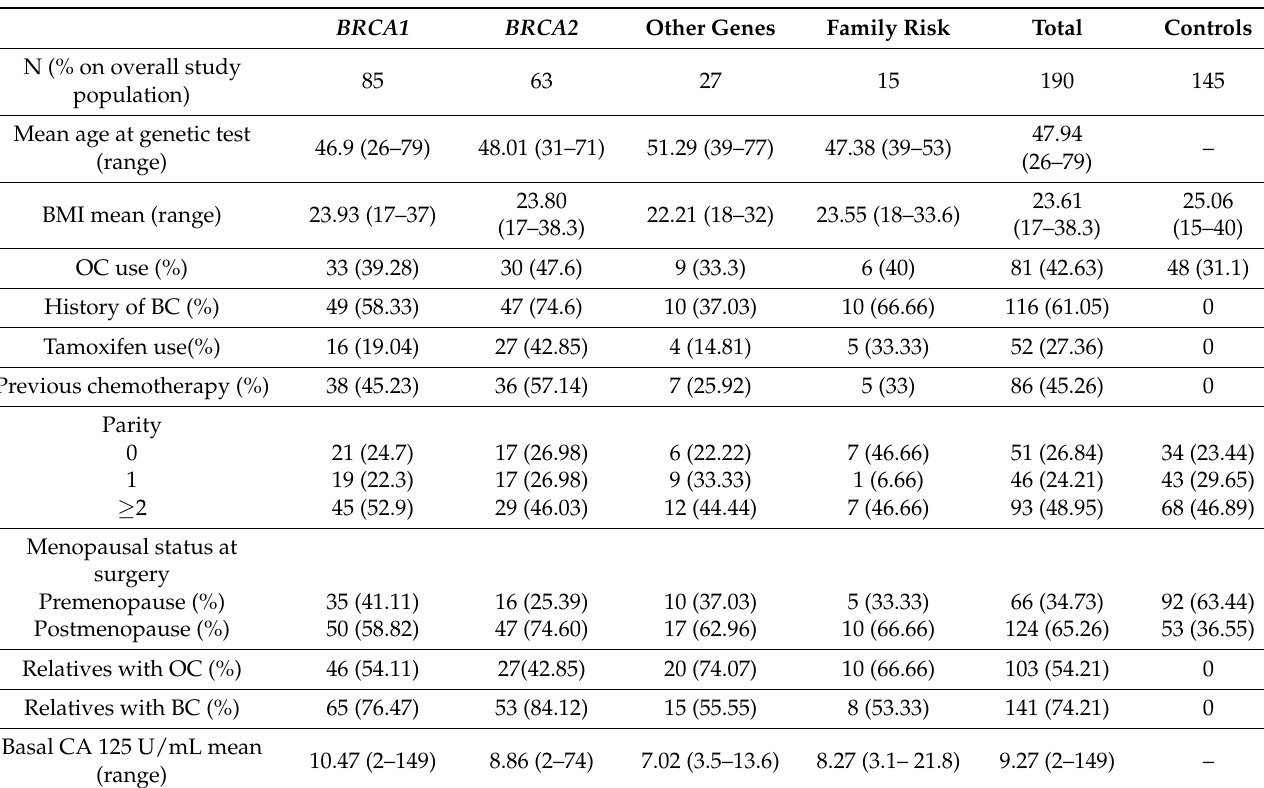
Table 1. Baseline and clinical features of study population according to mutation status.